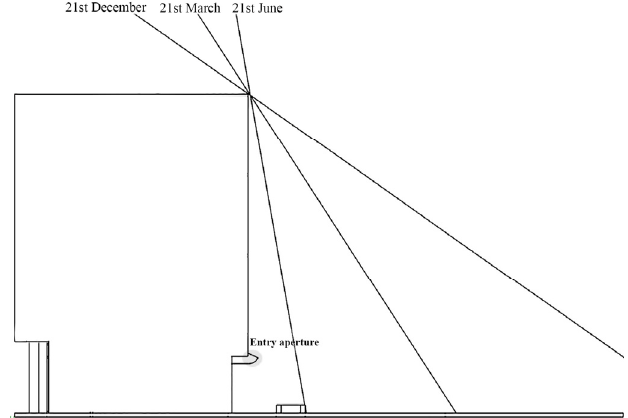
Figure 24. Solar altitudes of 21 st of March, June, and December in relation to the entry aperture of the northern anidolic ducts.